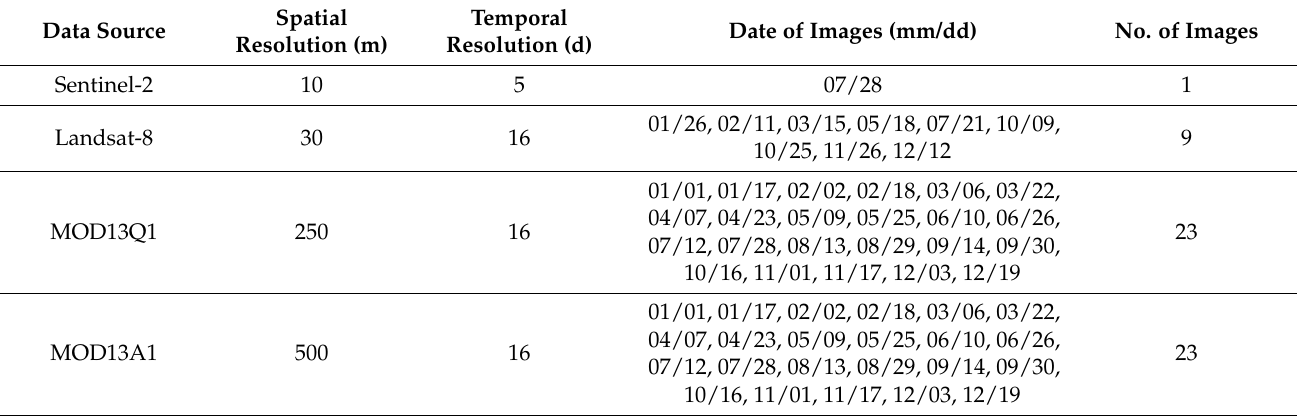
Table 1. Details of the remote sensing images used in this